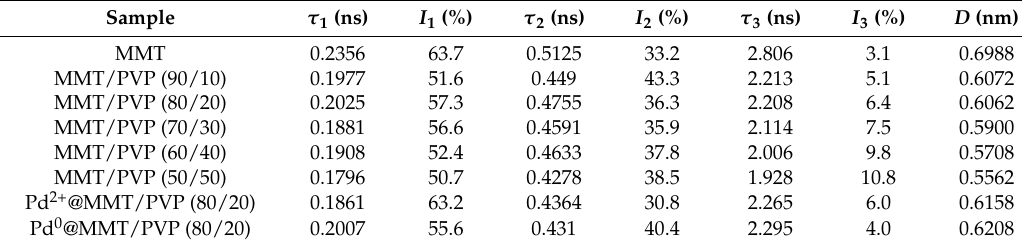
Table 1. Variation of positron annihilation lifetimes, intensities, and mean diameter of micro-defects